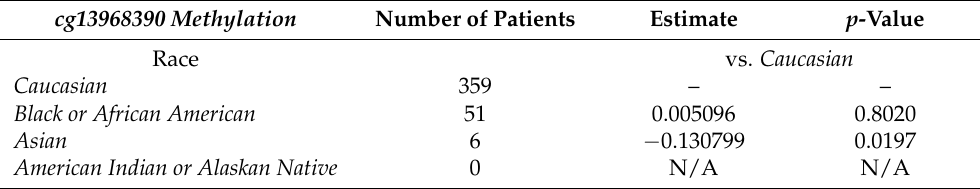
Table 3. The effect of race on SULT1C2 promoter methylation levels in TCGA LUAD dataset. Univariate linear regression was used on the indicated clinical feature. Bolded p value was considered